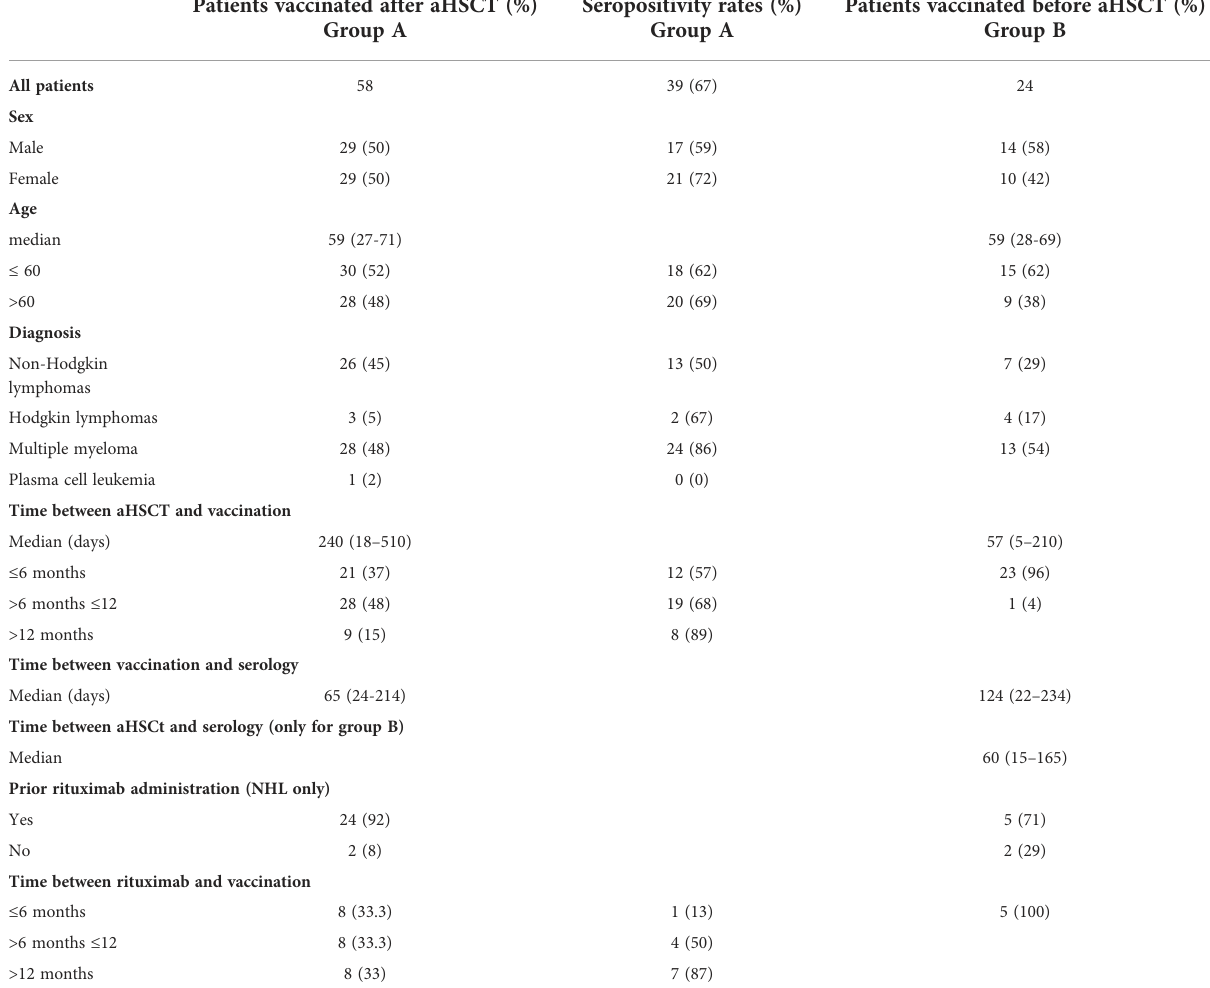
TABLE 1 Demographic, clinical characteristics, and seropositivity rates of patients who underwent aHSCT. Patients vaccinated after aHSCT (%) Group